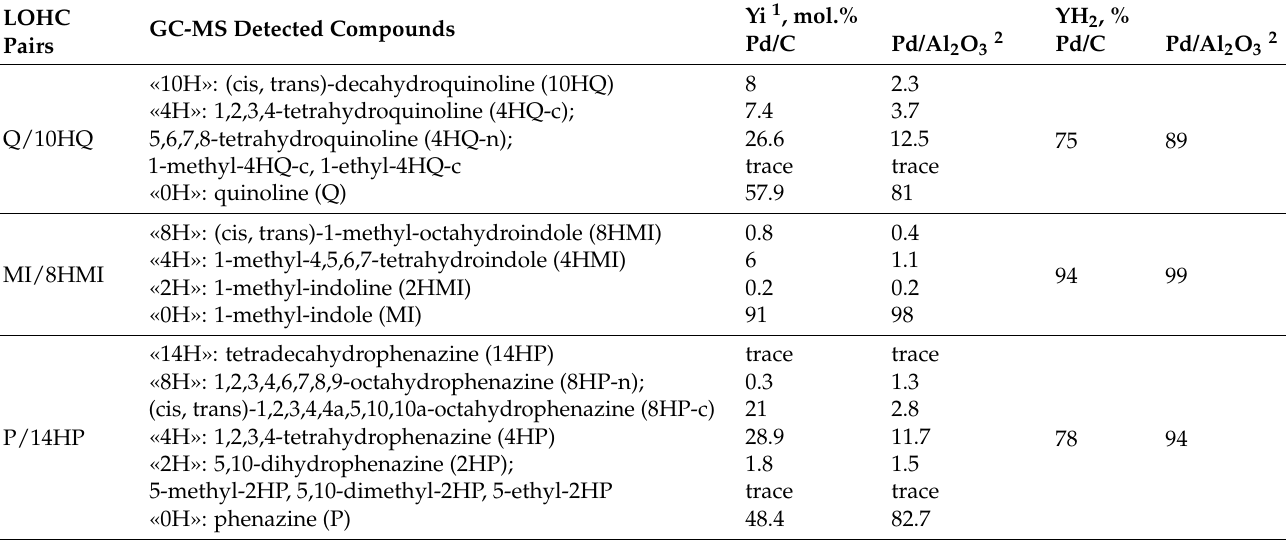
Table 2. Distribution of dehydrogenation products of nitrogenous heterocycles 10HQ, 14HP, and